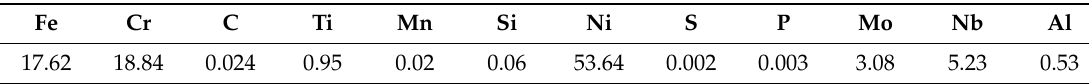
Table 2. Chemical composition of Alloy 718 in wt %.